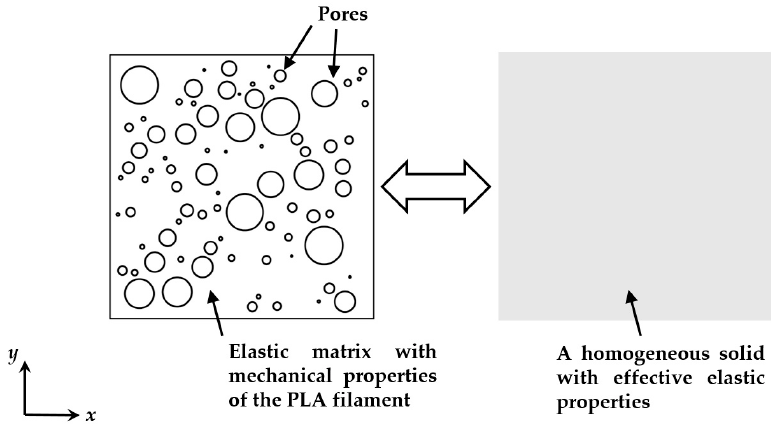
Figure 11. A sketch of the representative volume element and the equivalent homogeneous solid.